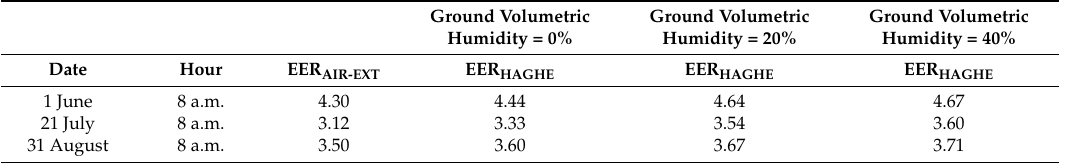
Table 6. Best values of EER (at T w = 10 °C), L = 30 m, H = 3 m, G = 833.33 m 3 /h.